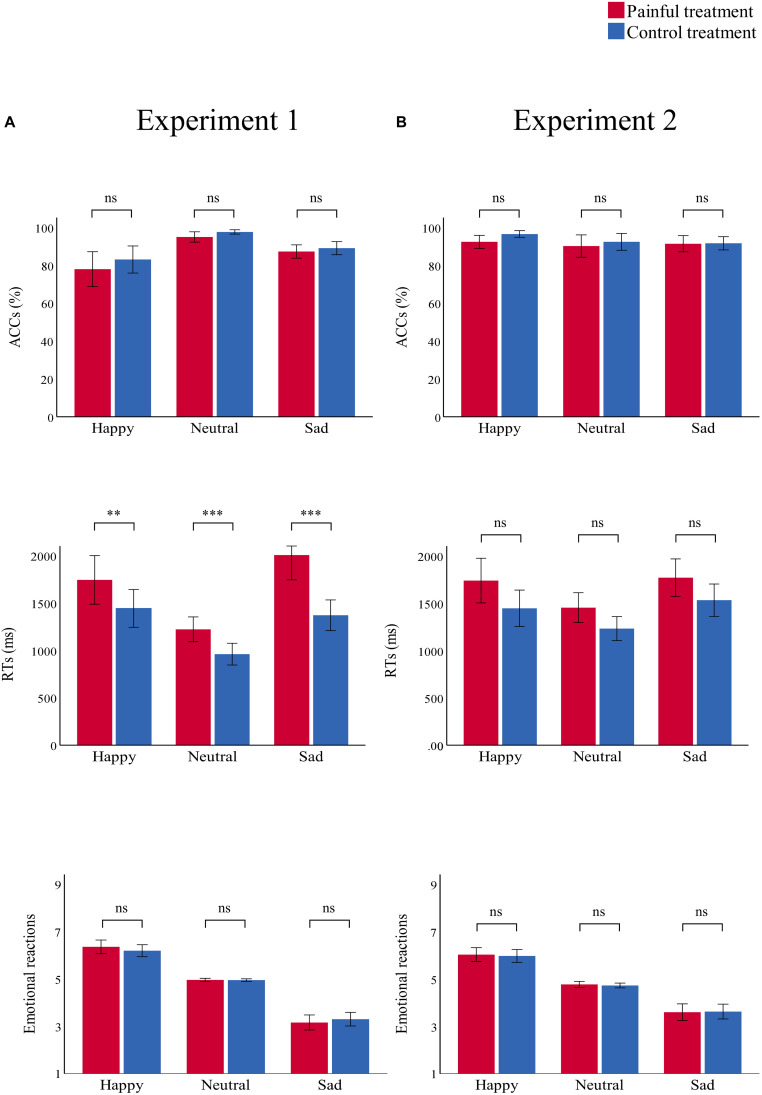
Bar charts representing the results of “treatment” × “emotion” interactions. RTs (top panel), ACCs (middle panel), and emotional reactions (bottom panel) in the painful (red) and control treatment (blue) in (A) Experiment 1 and (B) Experiment 2. Data are expressed as mean ± SEM. ns: p > 0.05; **p < 0.01, ***p < 0.001.